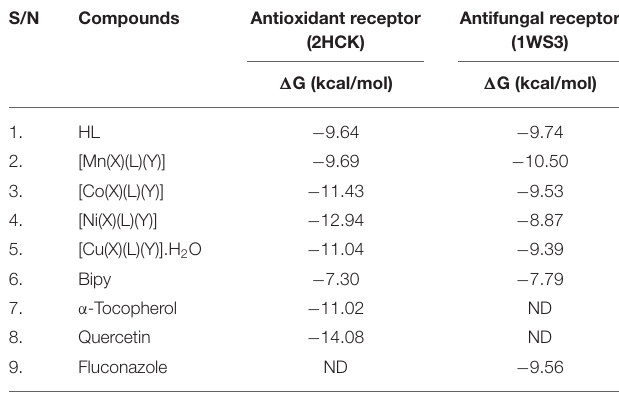
TABLE 5 | Binding free energies 1 G (kcal mol − 1 ) of compounds against drug